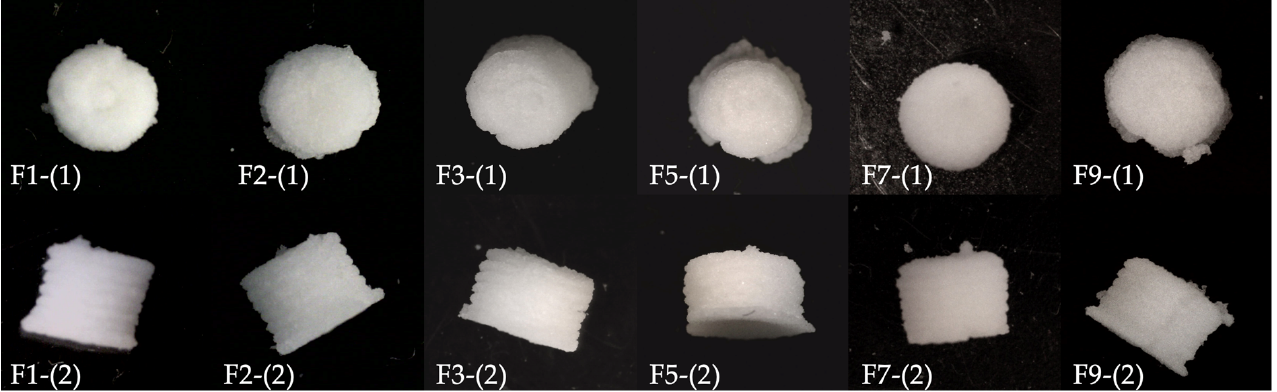
Figure 2. Appearance of ODMT formulation (post drying for 24 h) in DoE: F1-(1), F2-(1), F3-(1), F5-(1), F7-(1), F9-(1): top view; F1-(2), F2-(2), F3-(2), F5-(2), F7-(2), F9-(2): side view. Table 7. Characterisation of ODMT formulation in DoE. Formulation